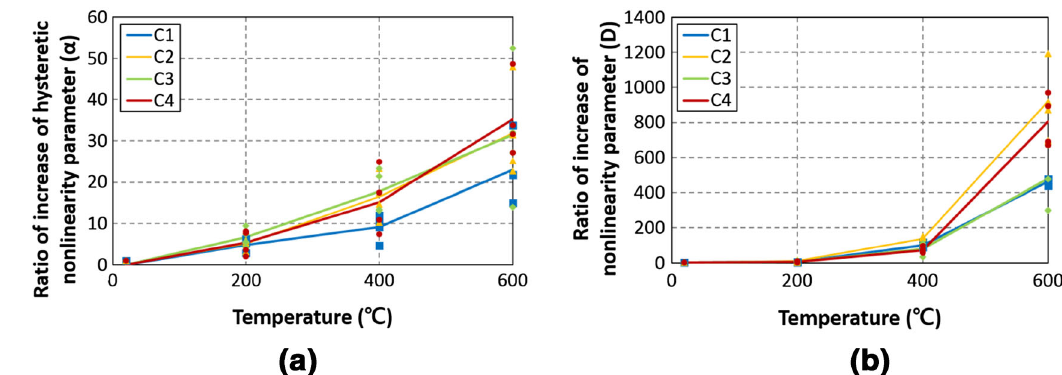
Fig. 6 Comparison of ratio of increase of the nonlinearity parameters at various temperatures. a Nonlinear resonance vibration method and b nonlinear modulation